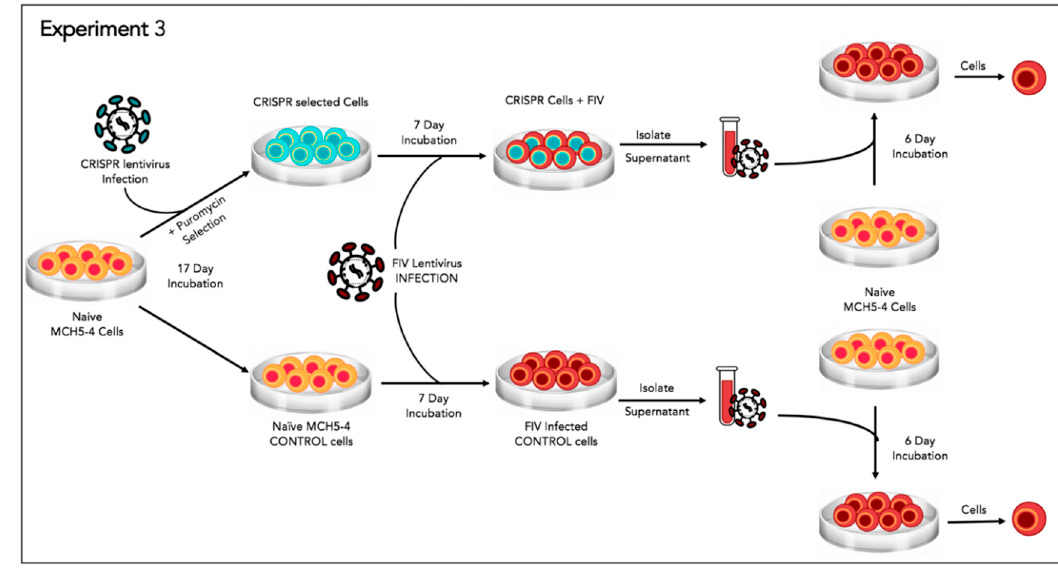
Figure 6. Schematic diagram of Experiment 3.